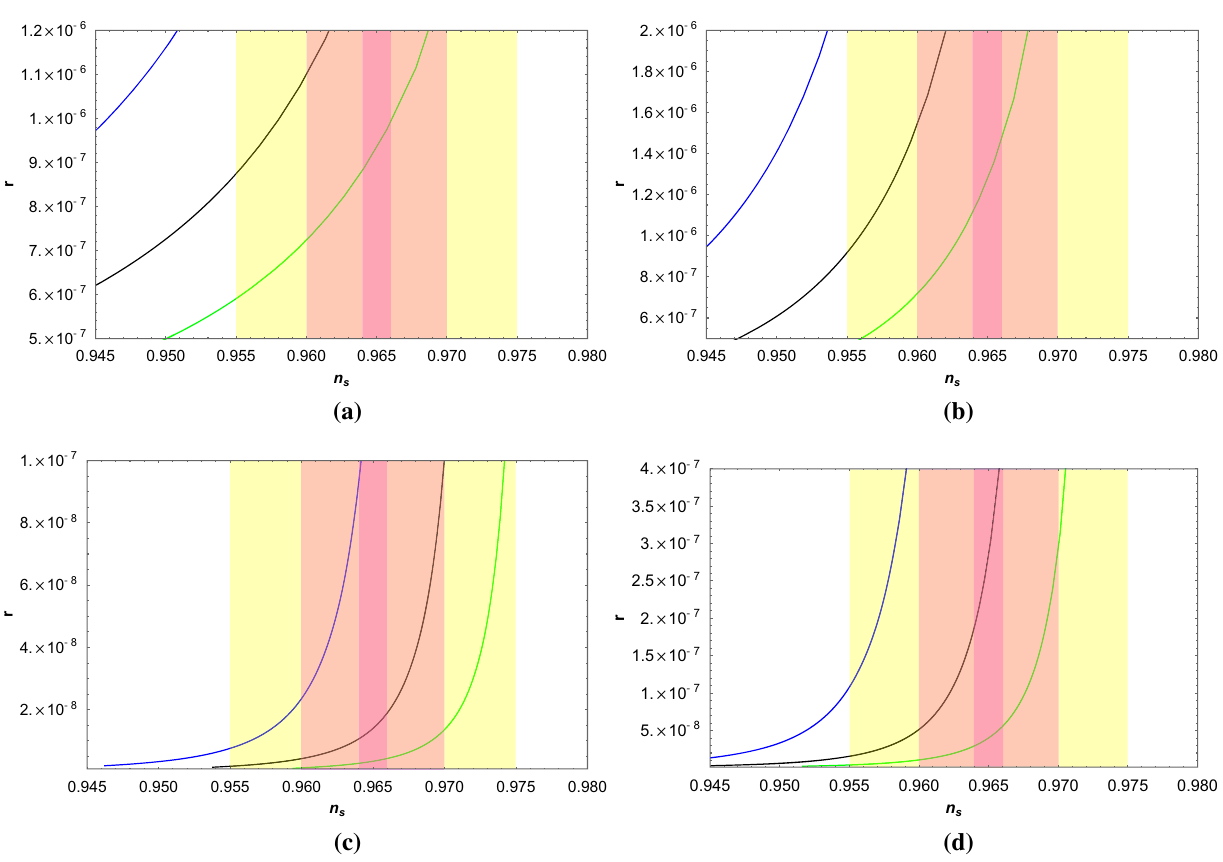
The light pink shaded region corresponds to the 1- σ bound and the yellow shaded region is 2- σ bound on n s from Planck’18 [TT,TE, EE+lowE+lensing+BK15]. The dark pink shaded region corresponds to the 1- σ bound of future CMB observations using same central value for n s